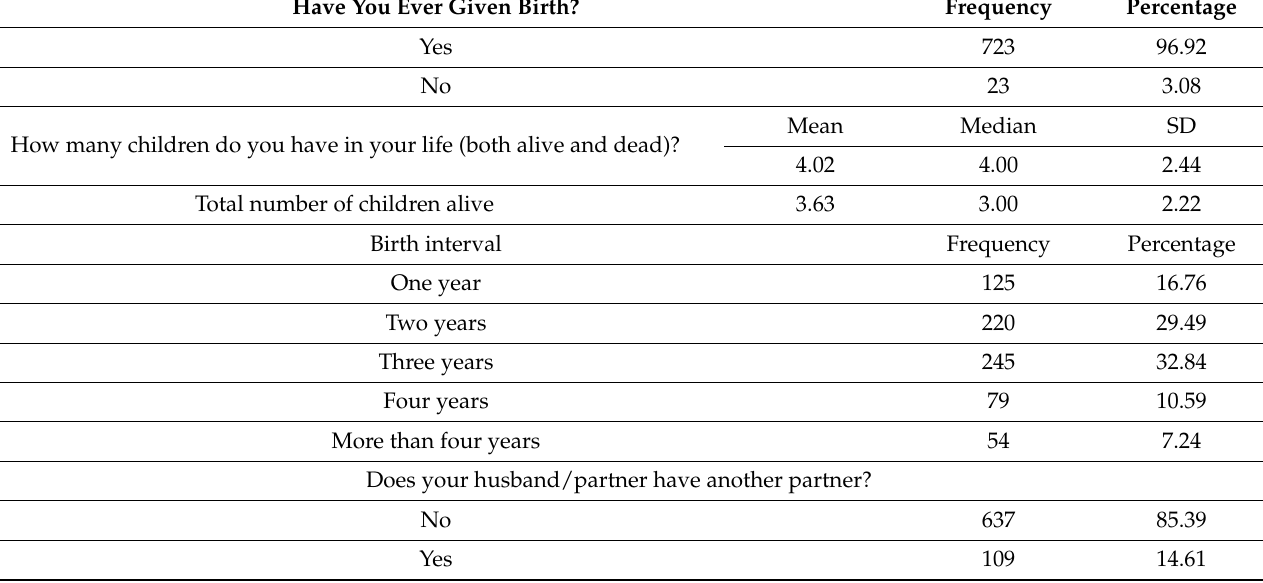
Table 2. Birth, age at first marriage and fertility among married women in Jimma Zone, Western Ethiopia, 2020. Have You Ever Given Birth?